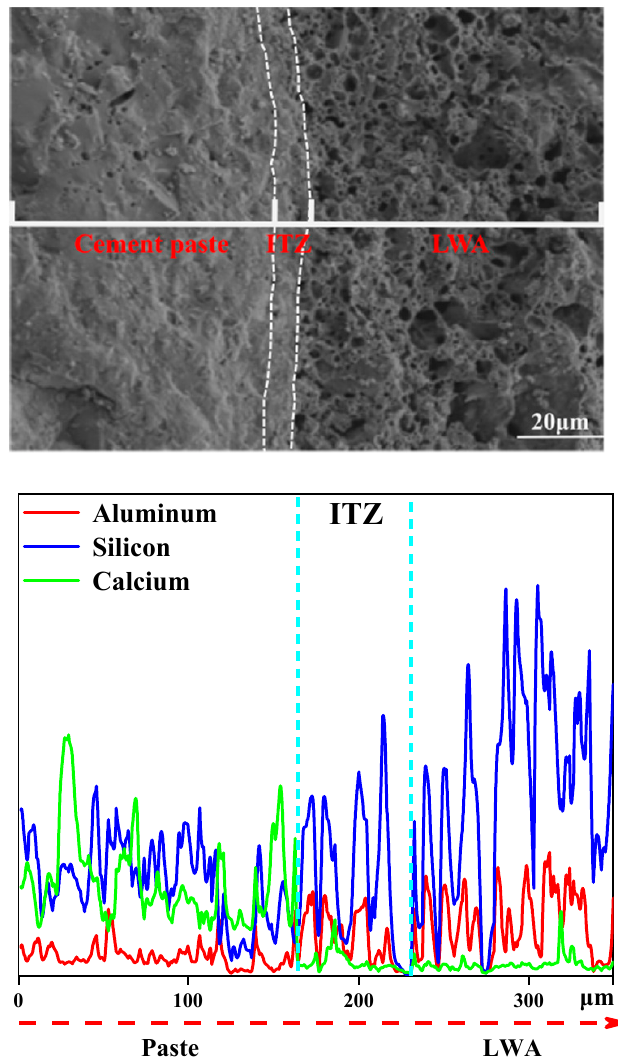
Figure 2. Interface element distribution.